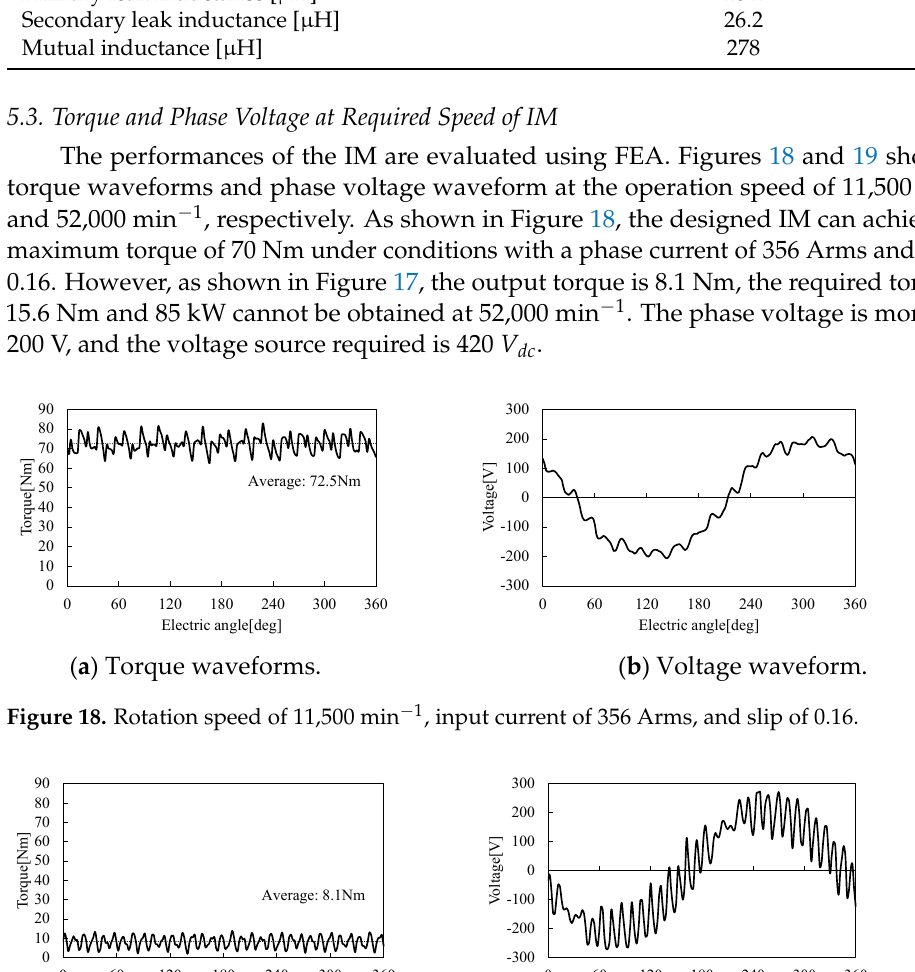
( a ) Torque waveforms. ( b ) Voltage waveform. Figure 19. Rotation speed of 52,000 min − 1 , input current of 159 Arms, and slip of 0.096.